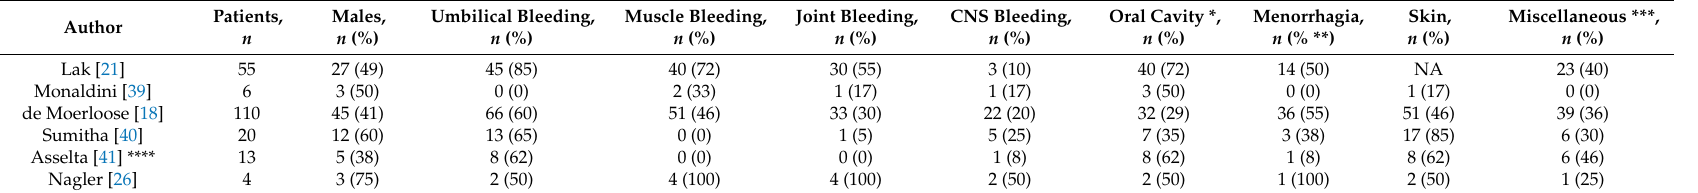
Table 1. Clinical manifestations reported in selected series of afibrinogenemic